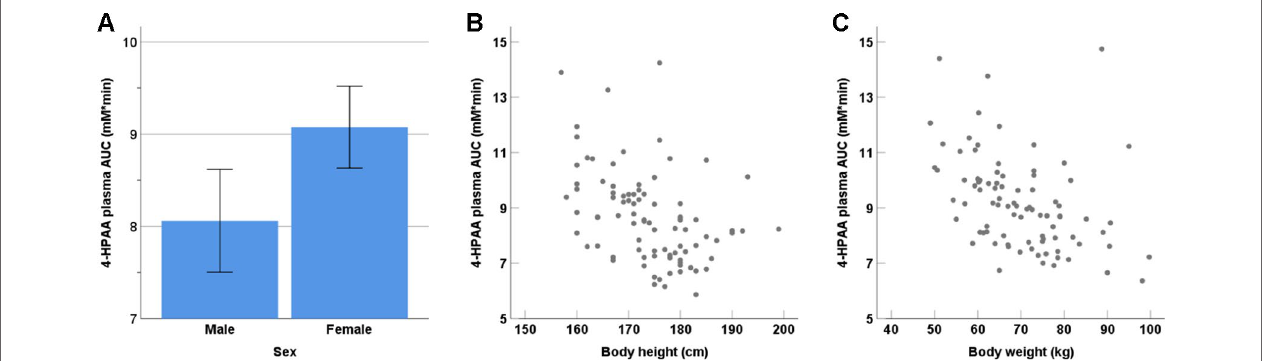
FigUre 4 | Dependence of the tyramine metabolite 4-HPAA on (A) sex (p = 0.001), (B) body height (p < 0.001; two-tailed), and (C) body weight (p < 0.001; two-tailed).